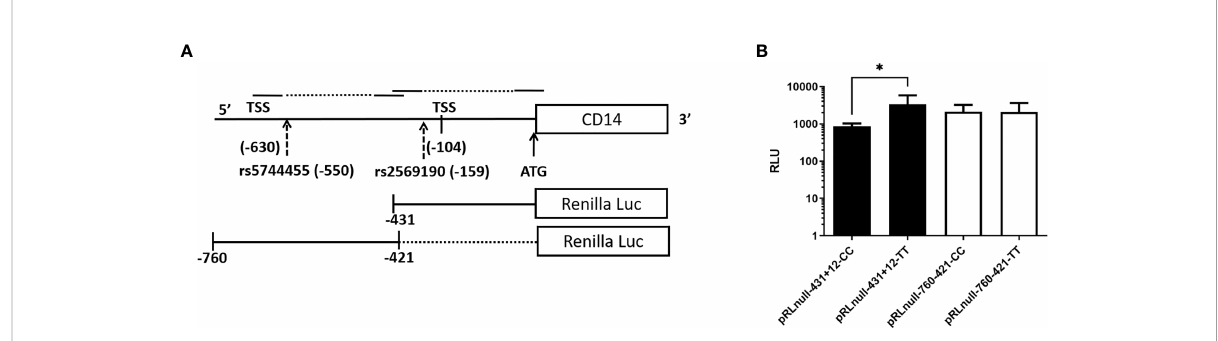
FIGURE 6 Renilla luciferase reporter constructs and the effect of polymorphisms affecting promoter activity. (A) Schematics of the promoter region and SNP positions (B) Effect of polymorphisms on promoter activity. TSS, Transcription start site; Luc, Luciferase; RLU, Relative Luminescence Unit, *Signi fi cant p-value,